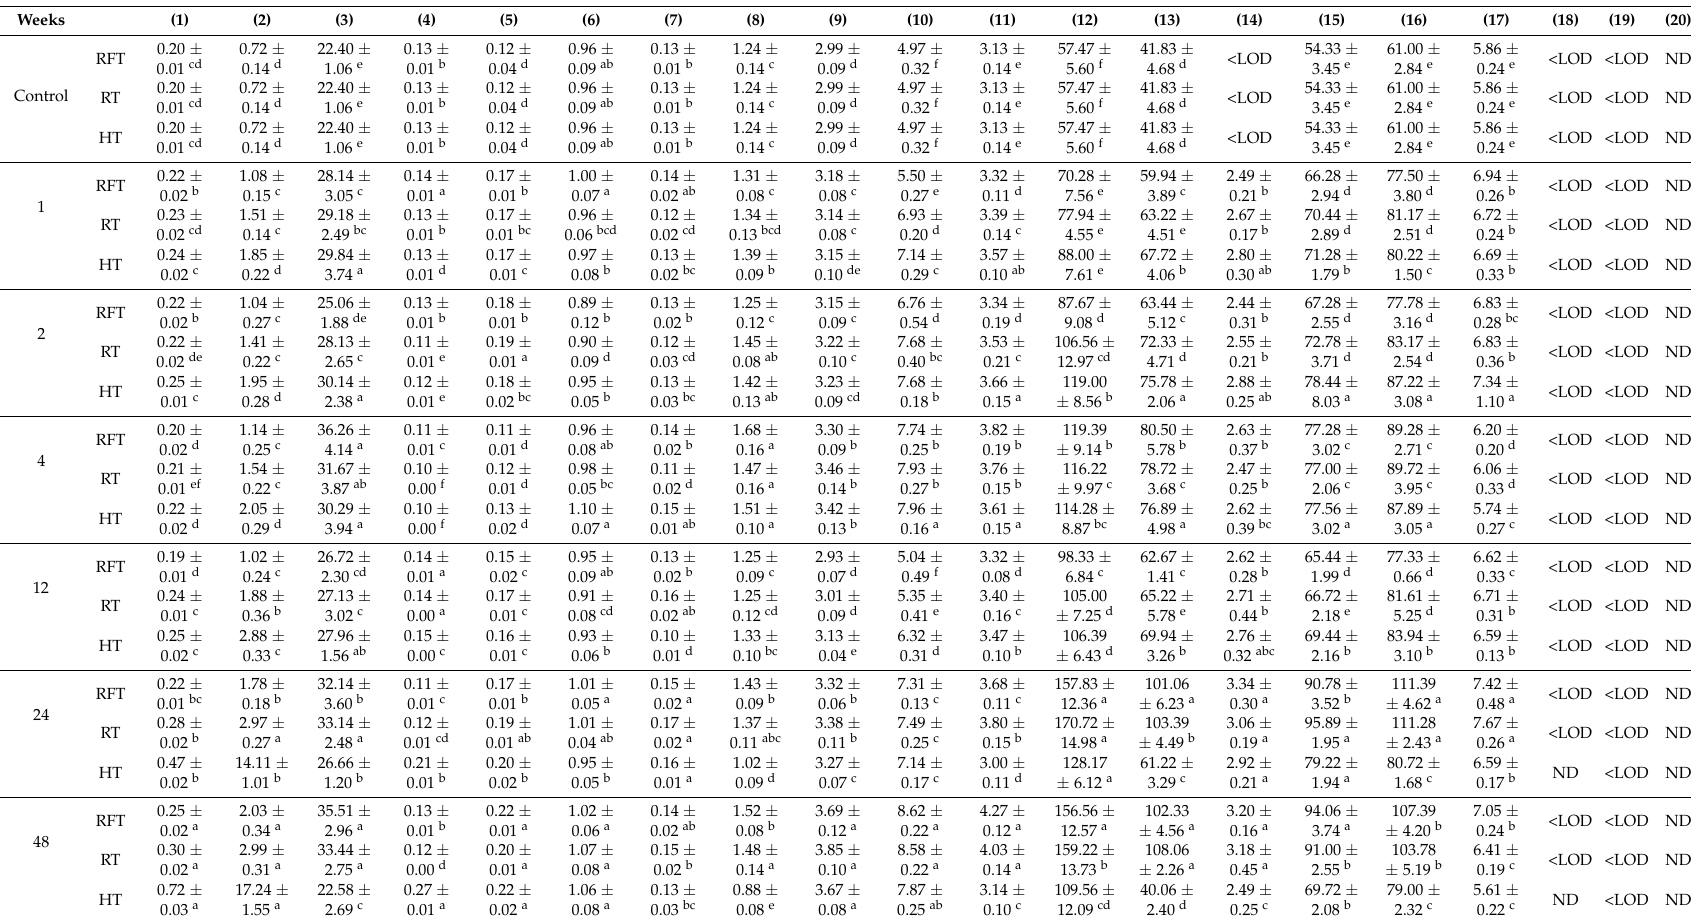
Table 2. Change of composition and content of PC in roasted soybean flour stored at 4, 20, and 45 ◦ C ( µ g/g on dry weight